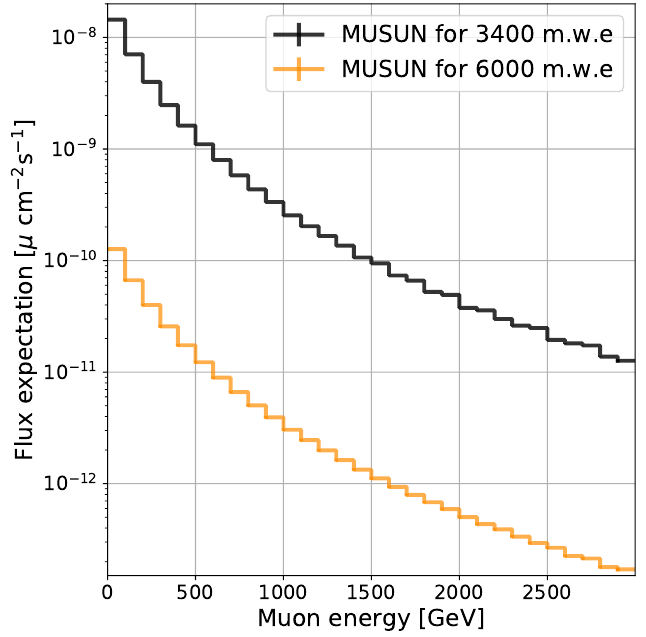
Figure 4 . Expected muon flux at LNGS (3400 m.w.e.) and SNOLAB (6000 m.w.e.) estimated with the MUSUN muon-transport simulation code